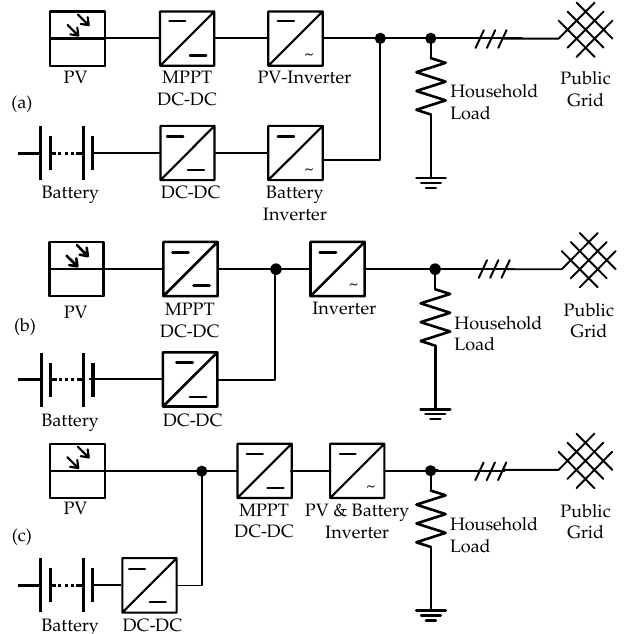
Figure 6. System coupling topologies and power electronic link for Photovoltaic BESS (PV-BESS): ( a ) AC coupled PV-BESS; ( b ) DC-link coupled PV-BESS; ( c ) Maximum power point tracker (MPPT)—coupled PV-BESS. Derivative of Figure by Truong et al. ([13]), used under